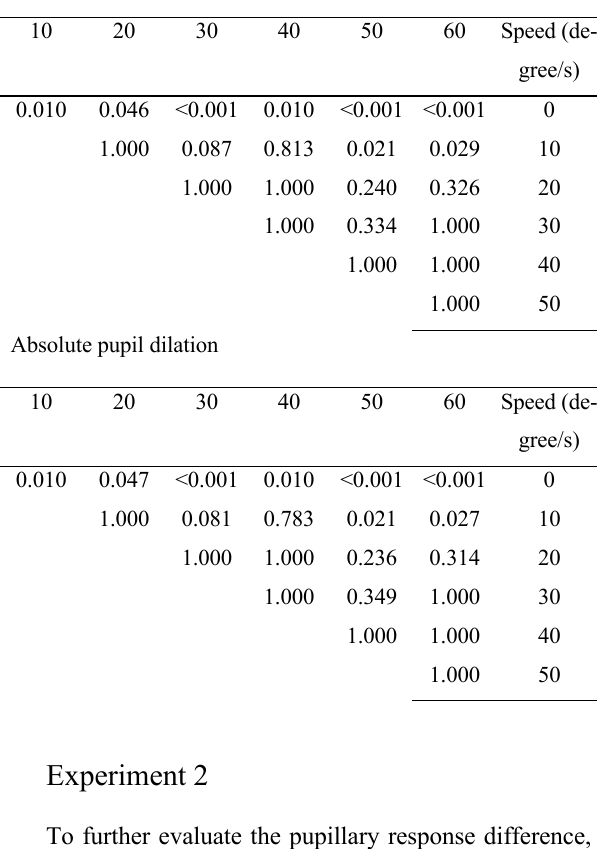
Table 2. P-value of comparison between speeds for relative and absolute pupil